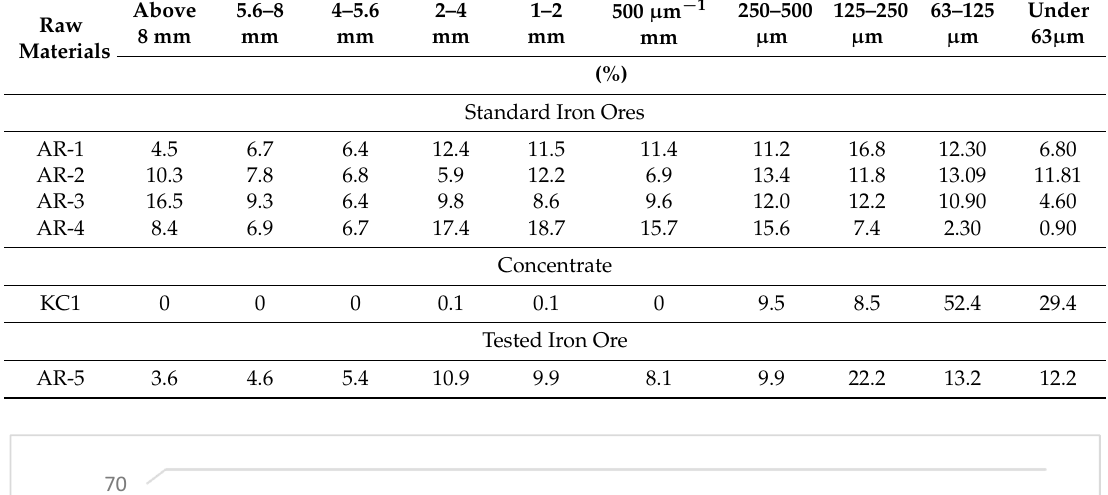
Table 4. Granulometric composition of used raw materials.